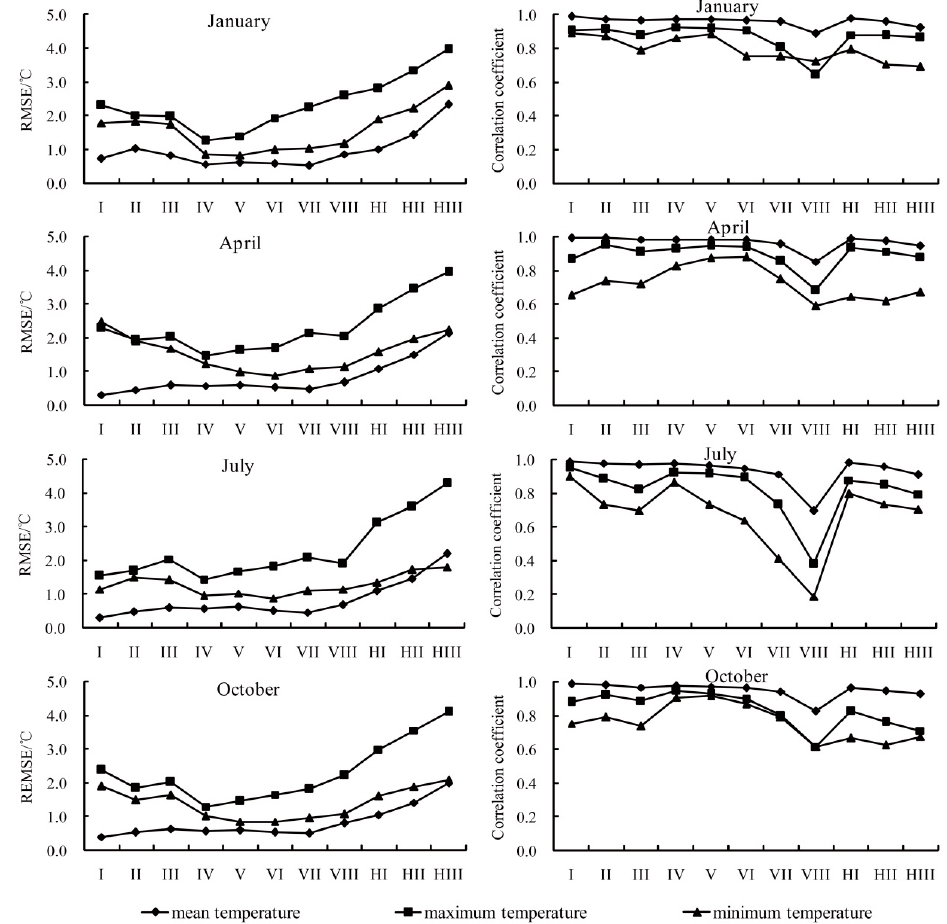
Figure 6. Root mean-square error (left) and correlation coefficient (right) of monthly temperature for January, April, July and October.